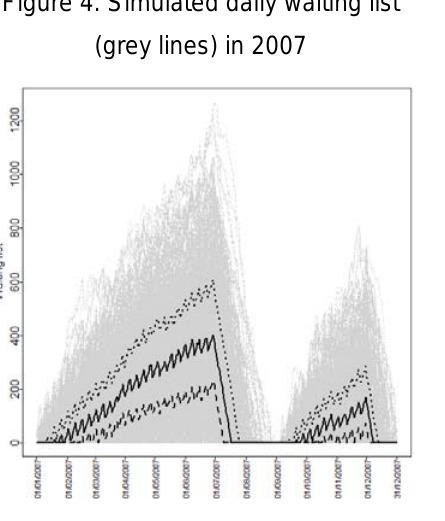
Occupancy rate quartiles are highlighted: 25 per cent (dashed black line), 50 per cent (solid black line), and 75 per cent (dotted black